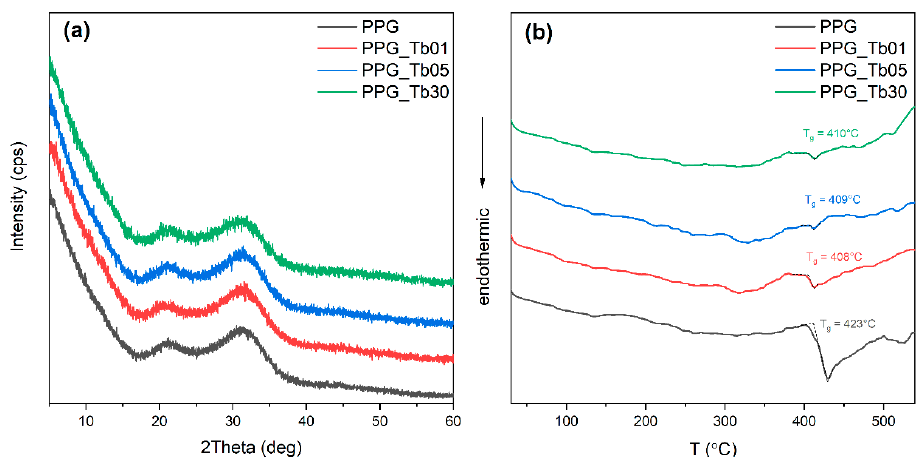
Figure 1. XRD patterns ( a ) and DSC traces ( b ) of synthesized phosphate glasses.